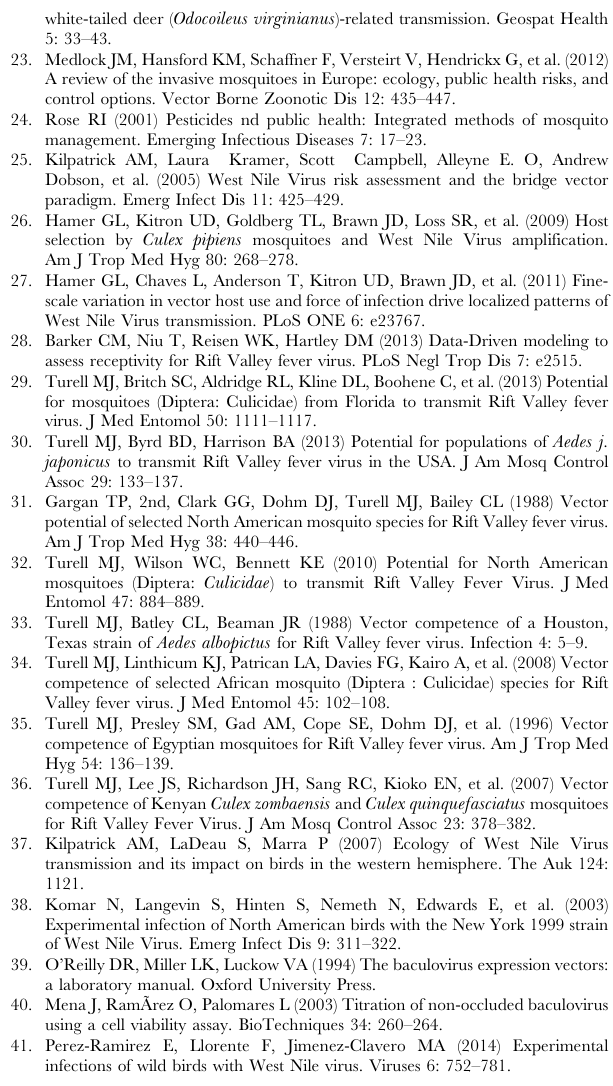
Table S3 Vector competence data, vertebrate competence data, and mosquito feeding patterns were combined to estimate the Rift Valley fever virus amplification fraction displayed by the vectors and vertebrates in the United States. In the F vi equation ( F vi = B i 2 * C i * C v ), the number of infectious mosquitoes resulting from feeding on a vertebrate host, Fvi, is equal to vertebrate host competence (C i : located in row 5), multiplied by the vector competence (C v : located in column C), multiplied by the fraction of the total blood meals from host i squared (B i 2 : indicated in each cell as a number divided by total blood meals in column B). All F vi values reflecting a vector-vertebrate pair were summed for each mosquito species (Column AC) and summed for each vertebrate species (Row 49). To present these values as a % risk (Column AD) the values of the vector amplification fraction were weighted over the total amplification demonstrated by all vectors, then multiplied by 100. To express the vertebrate contribution to RVFV amplification as a % risk (Row 50), the amplification values at the taxonomic resolution of Family and Order were weighted over the total amplification estimated by all mammals (Cell: Y49), then multiplied by 100. Because some blood meal data was only specific to the Mammalian class, 6.3% of the estimated amplification